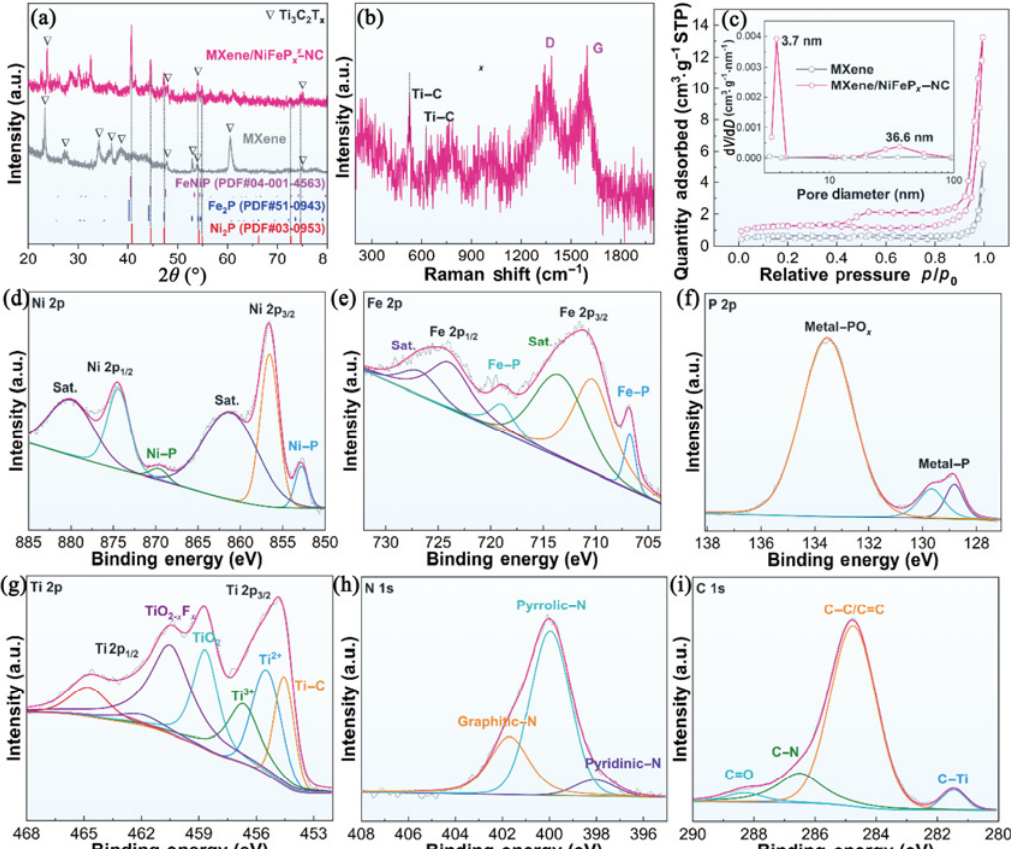
Fig. 2 (a) XRD patterns and (b) Raman spectra of Ti 3 C 2 T x MXene and MXene/NiFeP x –NC heterostructure. (c) N 2 adsorption– desorption isotherms of MXene and MXene/NiFeP x –NC heterostructure, wherein STP refers to standard temperature and pressure. XPS spectra of (d) Ni 2p, (e) Fe 2p, (f) P 2p, (g) Ti 2p, (h) N 1s, and (i) C 1s for MXene/NiFeP x –NC heterostructure, wherein “Sat.” refers to